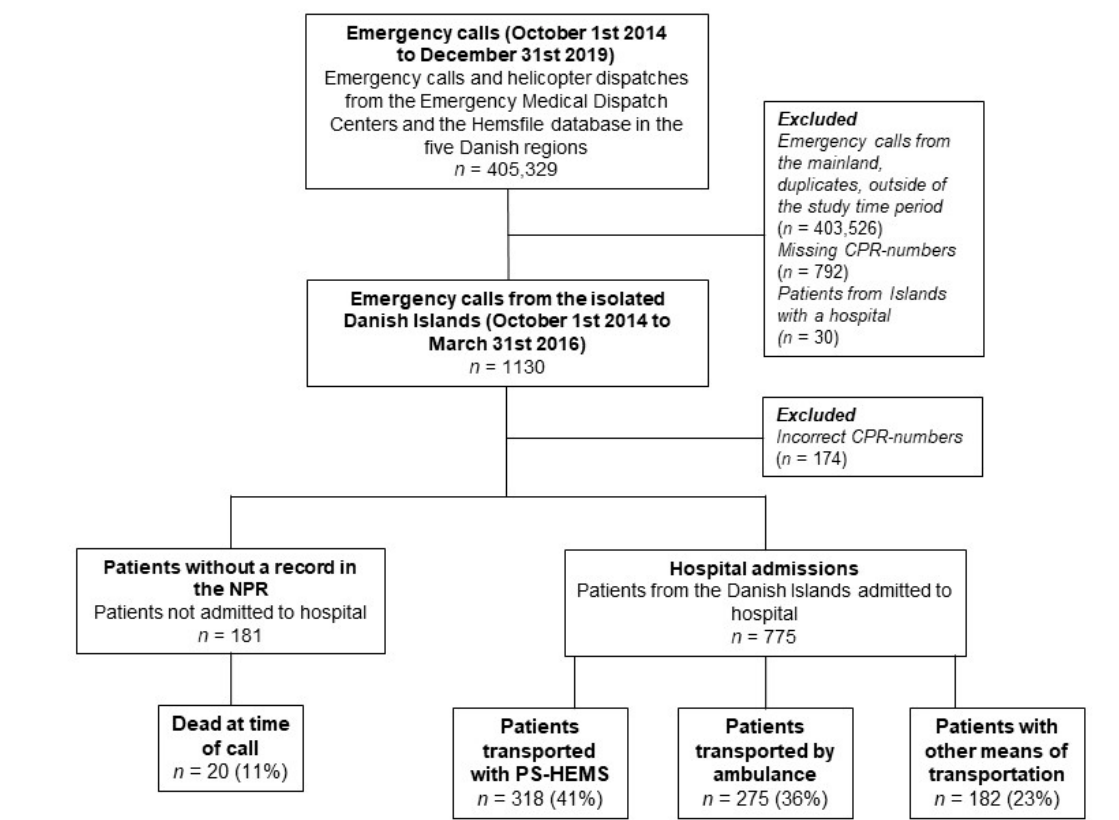
Figure 1. Flow chart of included patients with an emergency call from the isolated Danish Islands. Table 1. Characteristics of patients in need of emergency care from the isolated Danish